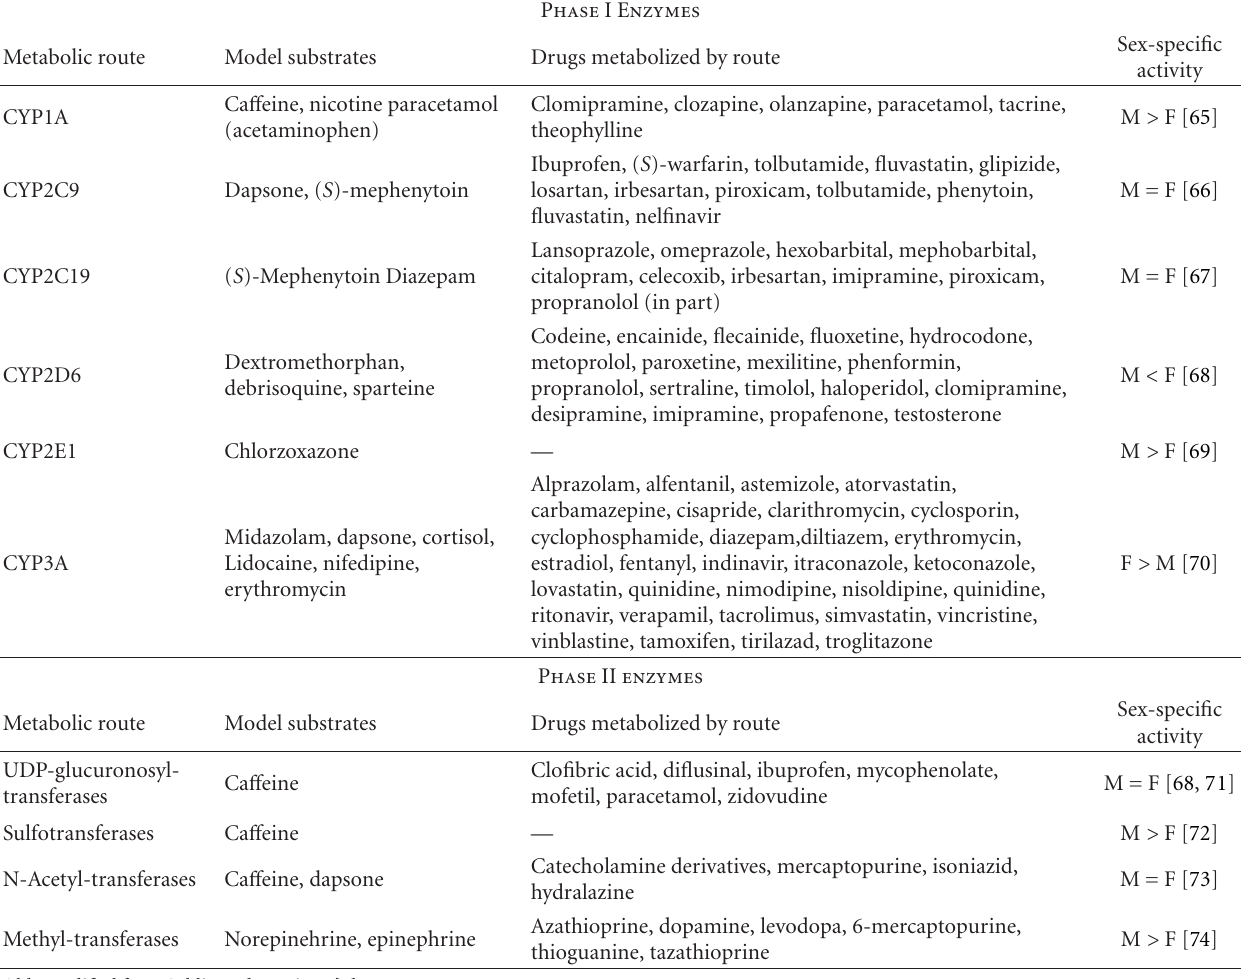
Table 3: Sex di ff erences in hepatic clearance by route of